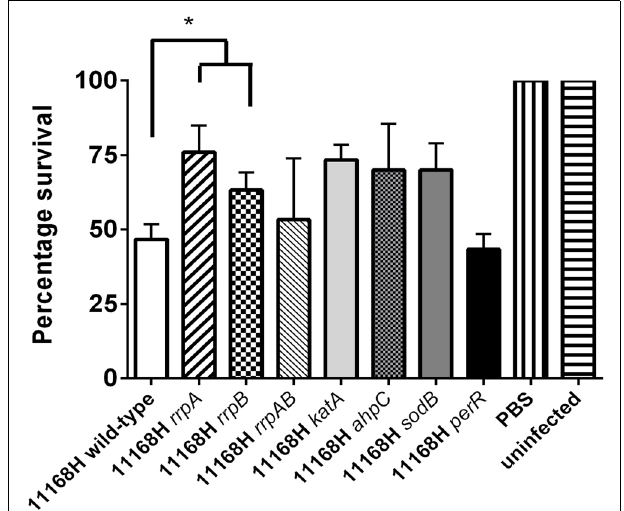
FIGURE 8 | Galleria mellonella infection model. G. mellonella larvae were injected with approximately 10 6 C. jejuni . Larvae were incubated at 37°C with survival detailed at 24 h. Brucella broth and no injection controls were used. For each experiment, 10 G. mellonella larvae were infected and experiments were repeated in triplicate. Asterisks denote a statistically significant difference (* p <